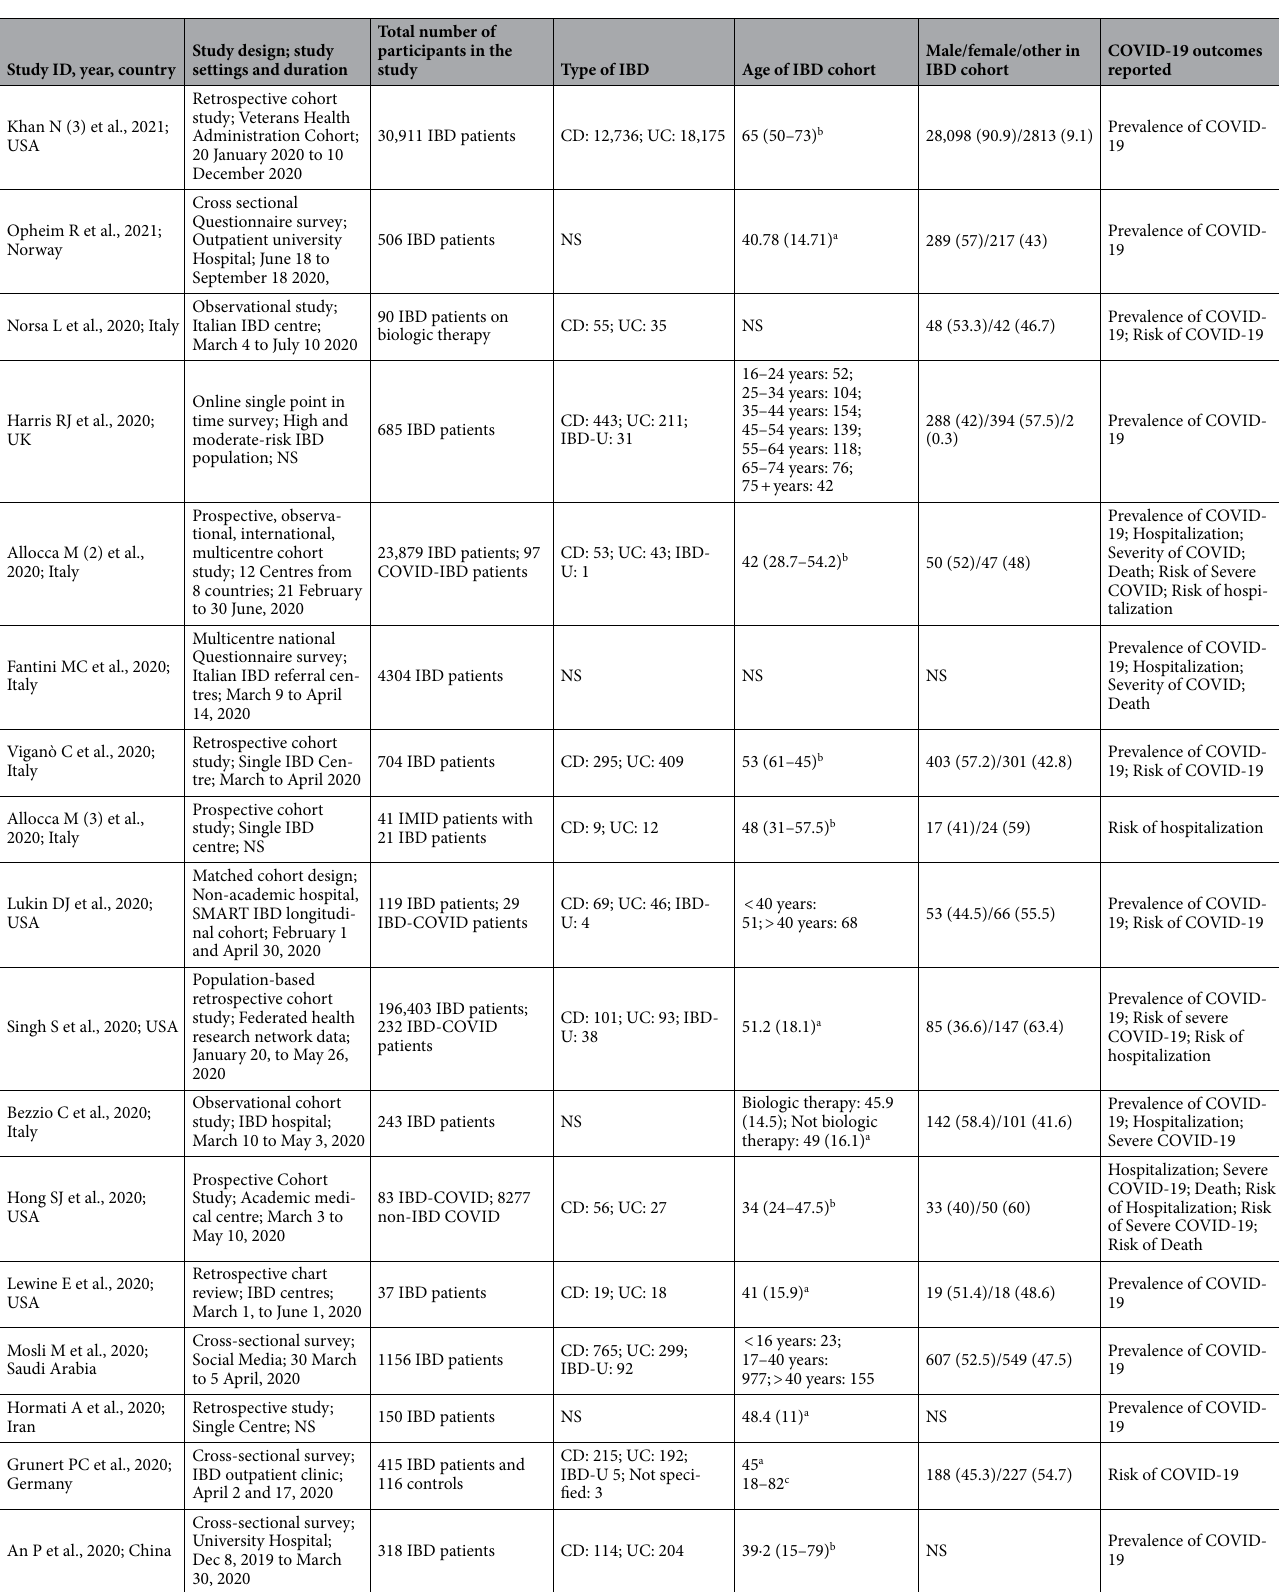
Table 1. Characteristics of the included studies and patients. CD Crohn’s disease, CC collagenous colitis, IBD inflammatory bowel disease, IBD‑U IBD-Unclassified, IMID immune-mediated inflammatory disease,